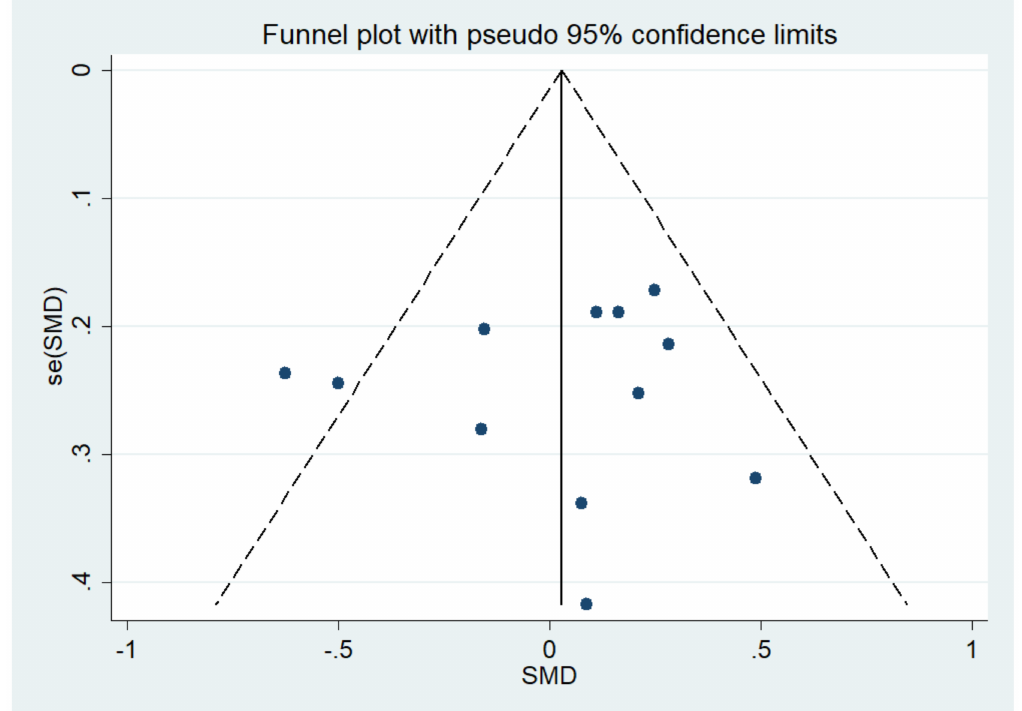
Figure 3. The funnel plot of the publication bias of